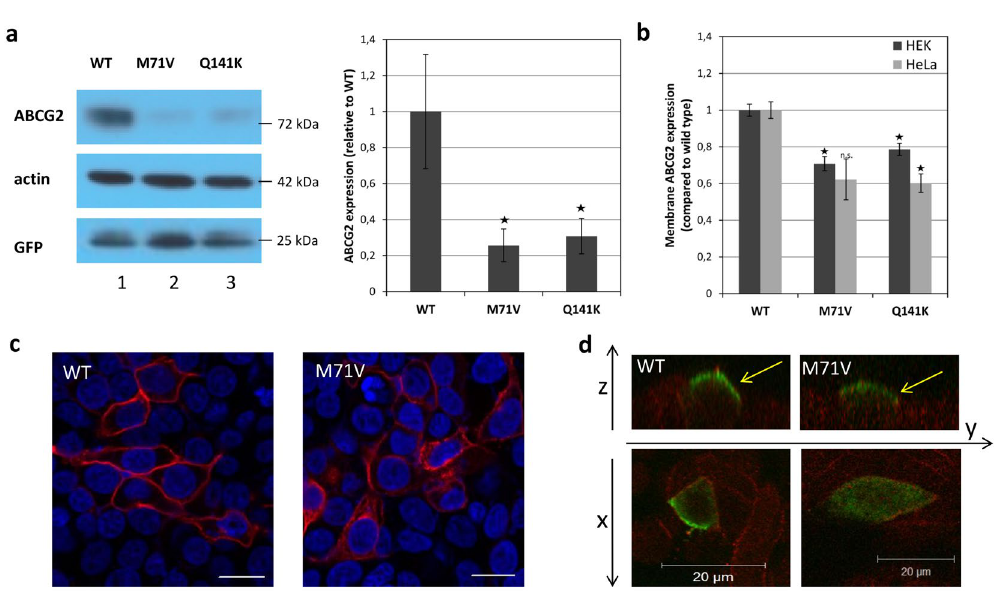
Figure 2. Determination of the expression and localization of ABCG2 variants in cellular systems in vitro . (Panel a) Expression of ABCG2 variants in HEK293 cells, detected by immunoblotting. Left Panel – immunoblot, Right Panel - expression levels of the wild type ABCG2, the ABCG2-M71V and the ABCG2- Q141K variants, normalized to beta-actin and presented as relative expression, compared to the ABCG2-Wt. Bars represents the mean relative expression ( ± SEM) from triplicate Western blots (Student’s t-test, * p < 0.05). The different proteins examined in the Western blot were developed by the respective antibodies and cropped from the indicated parts of the same gel and blot. (Panel b) Cell surface membrane expression of ABCG2 variants in HEK293 and HeLa cells, detected by the 5D3 antibody reacting with an extracellular epitope. Flow cytometry measurements ( ± SEM; Student’s t-test, * p < 0.05, ** p < 0.01, compared to the expression of the wild type ABCG2 in the same cell type). (Panel c) ABCG2 and ABCG2-M71V protein expression visualized by confocal microscopy in transfected HEK293 cells. ABCG2 is labeled with BXP-21 antibody (red), and nuclei are stained with DAPI (blue). Scale bars represent 20 µ m. (Panel d) Localization of ABCG2 and ABCG2-M71V protein as observed by confocal microscopy in transfected and polarized MDCKII cells. ABCG2 is stained with the BXP-21 antibody (green), and the basolateral membrane marker Na + /K + ATPase is stained with a specific antibody (red). Yellow arrows point to the apical